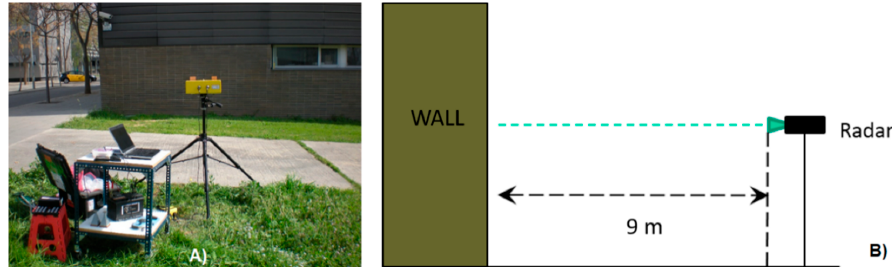
Figure 7. (A) Picture of the experiment setup. (B) Scheme of the measurements carried out to evaluate the response of the system with different polarization configurations in front of a perpendicular dielectric surface: A concrete wall.